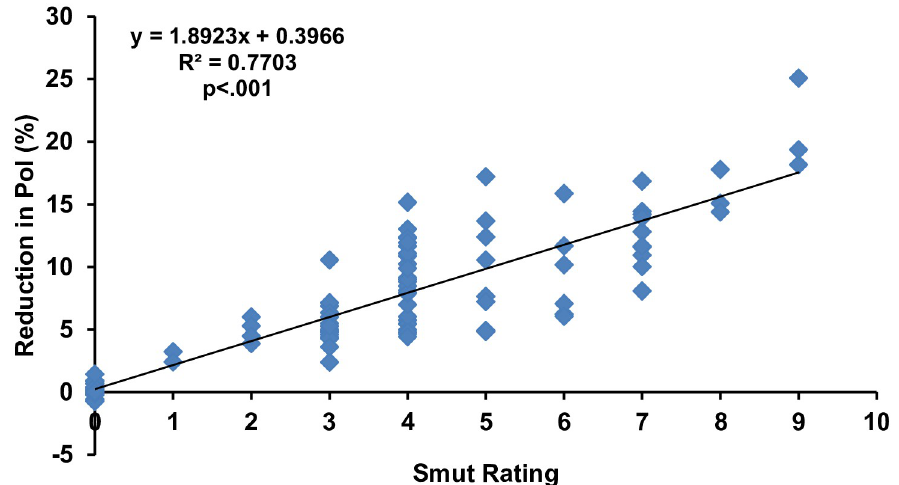
Fig 2. Regression analysis of pol percentage with whip smut disease rating. Note: The smut rating is not a linear scale. It’s based on the transformation explained in methods from linear incidence value to the rating. Accordingly, the resulting disease incidences were converted into 0–9 disease rating scale [41], where 0: no disease, 1: 0.1–2.5%, 2: 2.6– 5.5%, 3: 5.6–7.5%, 4: 7.6–12.5%, 5: 12.6–15.5%, 6: 15.6–18.0%, 7: 18.1–22.5%, 8: 22.6–25.5% and 9: 25.6–100%.